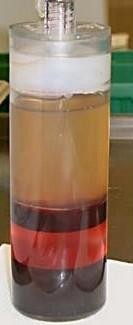
GPS®-Tube after centrifugation. The GPS® tube after centrifugation: The red blood cells fraction at the bottom of the tube is separated from the buffy coat by a buoy. The platelet-rich plasma is above and is separated from the platelet-poor plasma after the white plunger is manually pushed down.